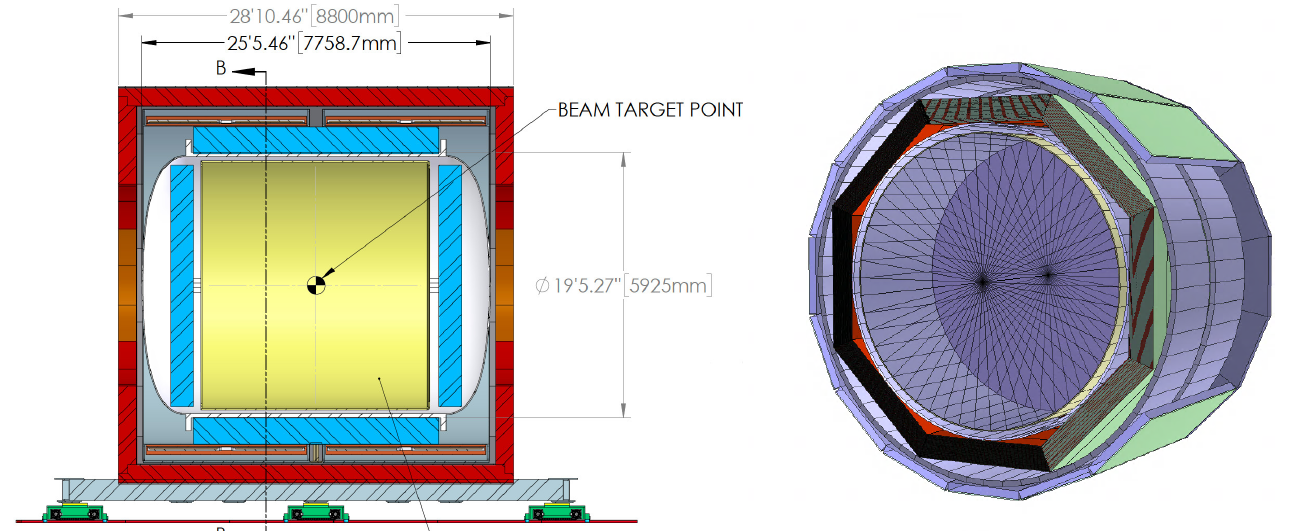
Figure 49. On the left, the conceptual design of ND-GAr. The ECAL (shown in blue) barrel is located outside the HPgTPC pressure vessel and the endcaps are inside. On the right, a conceptual design of the ECAL system represented by the octagon surrounding the